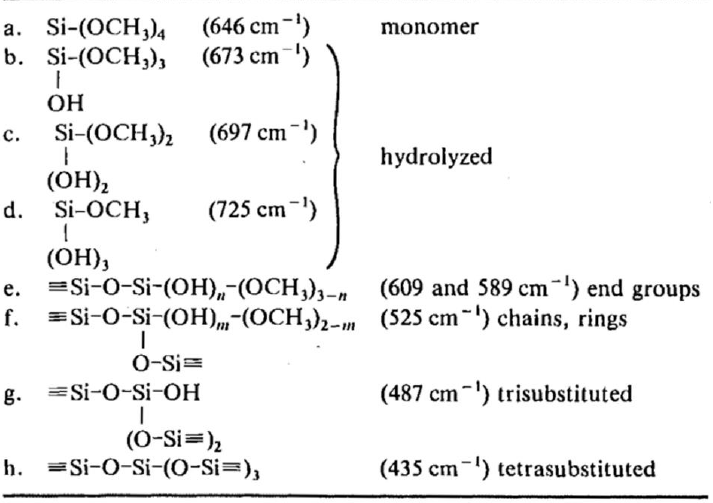
Polymers 2019 , 11 FOR PEER REVIEW 37 Figure 23. DRIFT spectra of 4-TBN on silica gel (a) at zero time after adsorption; (b) after 1 day; (c) after 3 days; (d) after 6 days; (e) after 8 days at room temperature and ( I ) water-saturated atmosphere, and ( II ) vacuum conditions. Reprinted with permission from [92]. Copyright Elsevier, 2005. It was shown [4] that the Raman and 29 Si NMR spectra for TMOS complemented each other well, but there was no mention of organo-functionalized silanes. Table 7 represents the Raman peaks for the tetra-functional silane species. The region between 200 and 1500 cm − 1 is the most useful region to study the kinetics of silanes, since there is a lot of interference in the higher wavenumber region [54] (Table 8). Ferri et al. [54] used Raman spectrometry to monitor the hydrolysis and condensation of octyl triethoxysilane (OES)/TEOS in real time during the coating process. They investigated the hydrolysis by monitoring the disappearance of peaks at 650 and 810 cm − 1 , which represent the Si-O breathing and CH 2 rocking of alkoxide, respectively, as well as the appearance of the peaks at 710 and 881 cm − 1